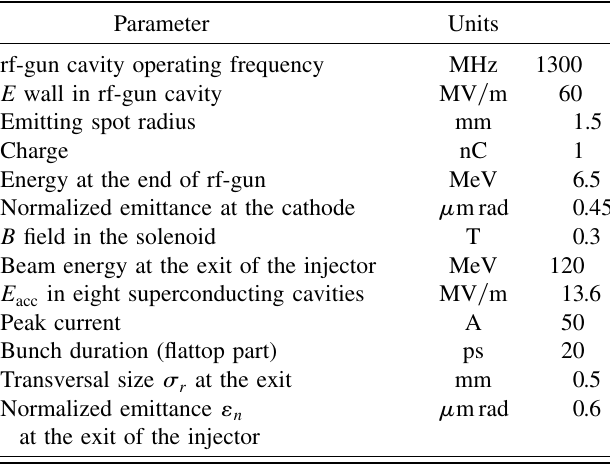
FIG. 6. (Color) Layout and beam functions of the split injector (acceleration and focusing take place at different longitudinal positions). TABLE I. Parameters of the beam and the injector.